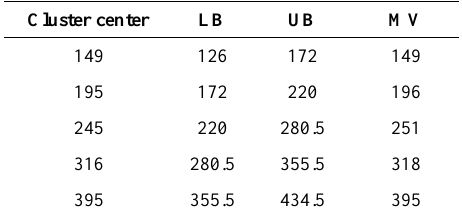
Table 20. Calculation of lower bound (LB), upper bound (UB), and middle value (MV)